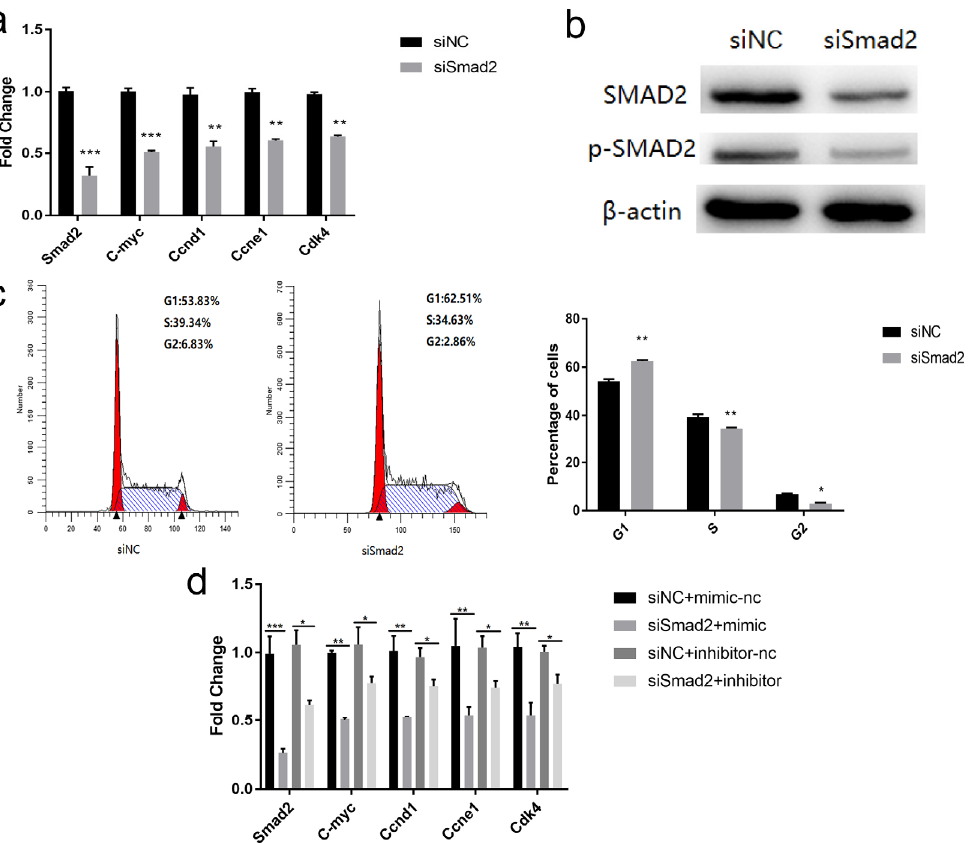
Figure 6. miR-152-3p inhibits the proliferation of MTEC1 cells by targeting Smad2 . ( a ) The expression level of the cell cycle-related genes was detected in the MTEC1 cells transfected with siRNA– Smad2 (si Smad2 ). ( b ) si Smad2 decreased the expression of the SMAD2 protein in the MTEC1 cells. ( c ) The effect of si Smad2 on MTEC1 cell cycle progression was measured using flow cytometry. ( d ) After co-transfection with miR-152-3p and si Smad2 , cell cycle-related gene expression was detected in the MTEC1 cells. The RT-qPCR data were normalized to the level of β -actin for mRNA. Data were expressed as mean ± SD for three biological replicates (Student’s t -test: *, p < 0.05; **, p < 0.01; ***, p < 0.001).